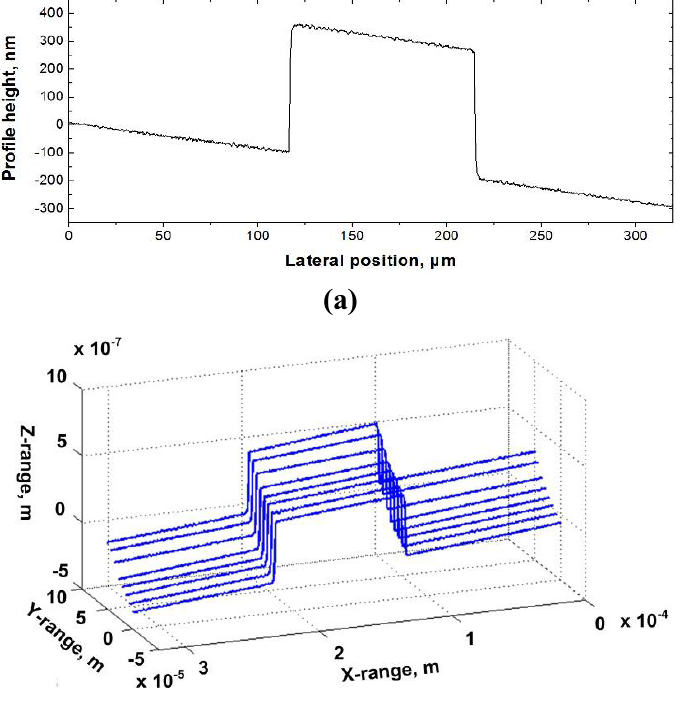
Figure 7. The cross section profile (a) and multiple scanning measured results (b) of 450 nm step